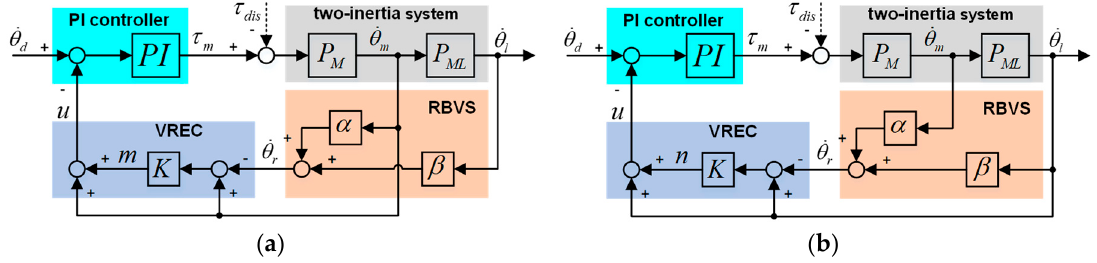
Figure 4. Block diagram of the proposed method: ( a ) the motor-side controller based on motor velocity feedback; ( b ) the link-side controller based on link velocity feedback.